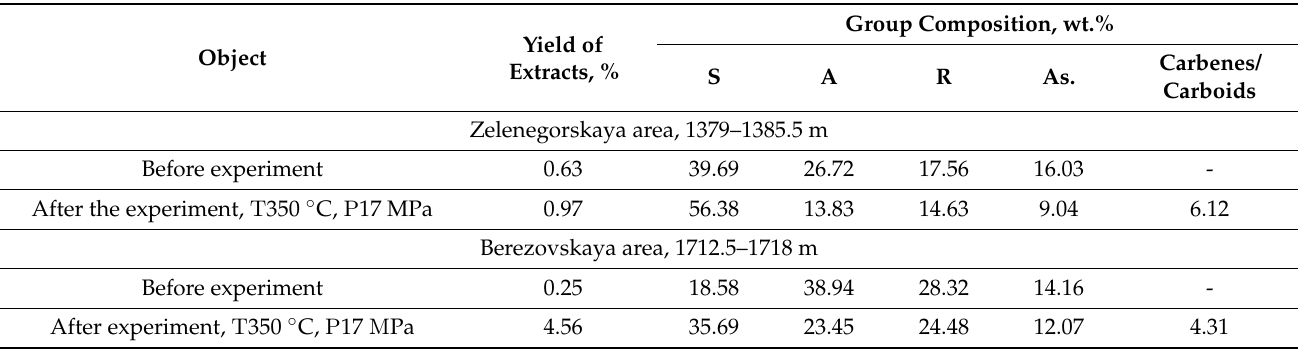
Table 2. Group composition (SARA analysis) of rock extracts before and after the experiments. Object